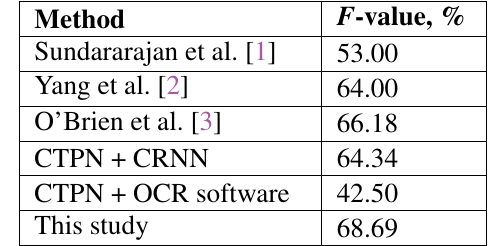
Table 1 Comparison of experimental results based on the SVT